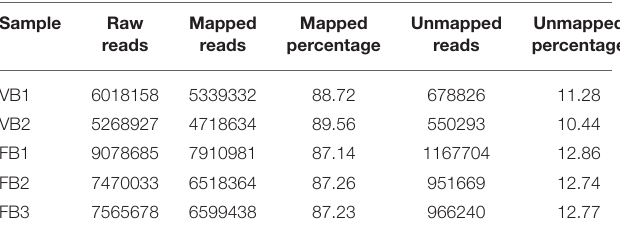
TABLE 1 | Statistics of raw and clean reads of small RNAs isolated from Malus domestica .